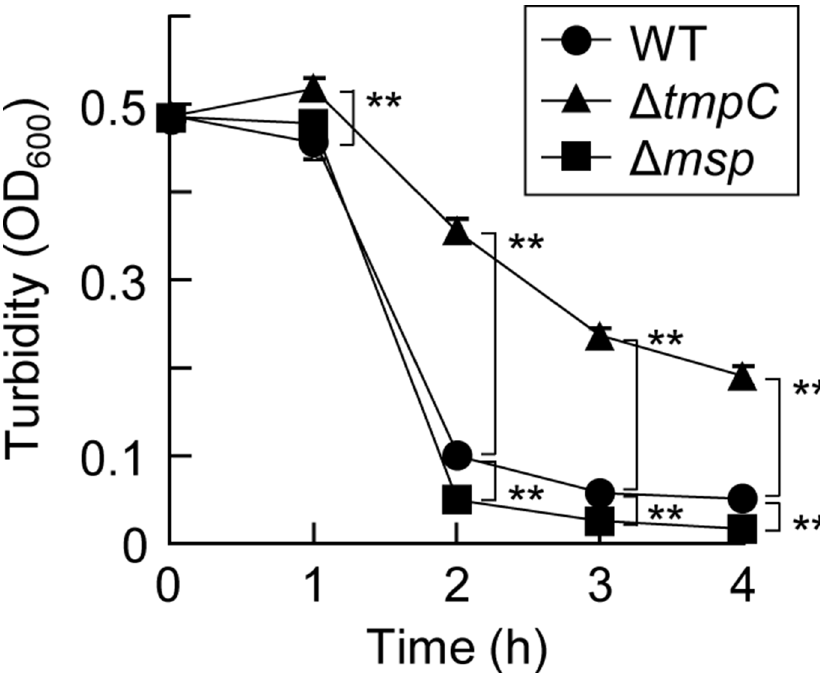
Figure 6. Autoagglutination assay. Autoagglutination was examined by monitoring the OD 600 of the surface of the cell suspension. The data presented show a representative result from three independent experiments and are expressed as the means 6 SD (n=3). A Dunnett’s test was performed to compare the wild type and mutants at each time point (**, P , 0.01).